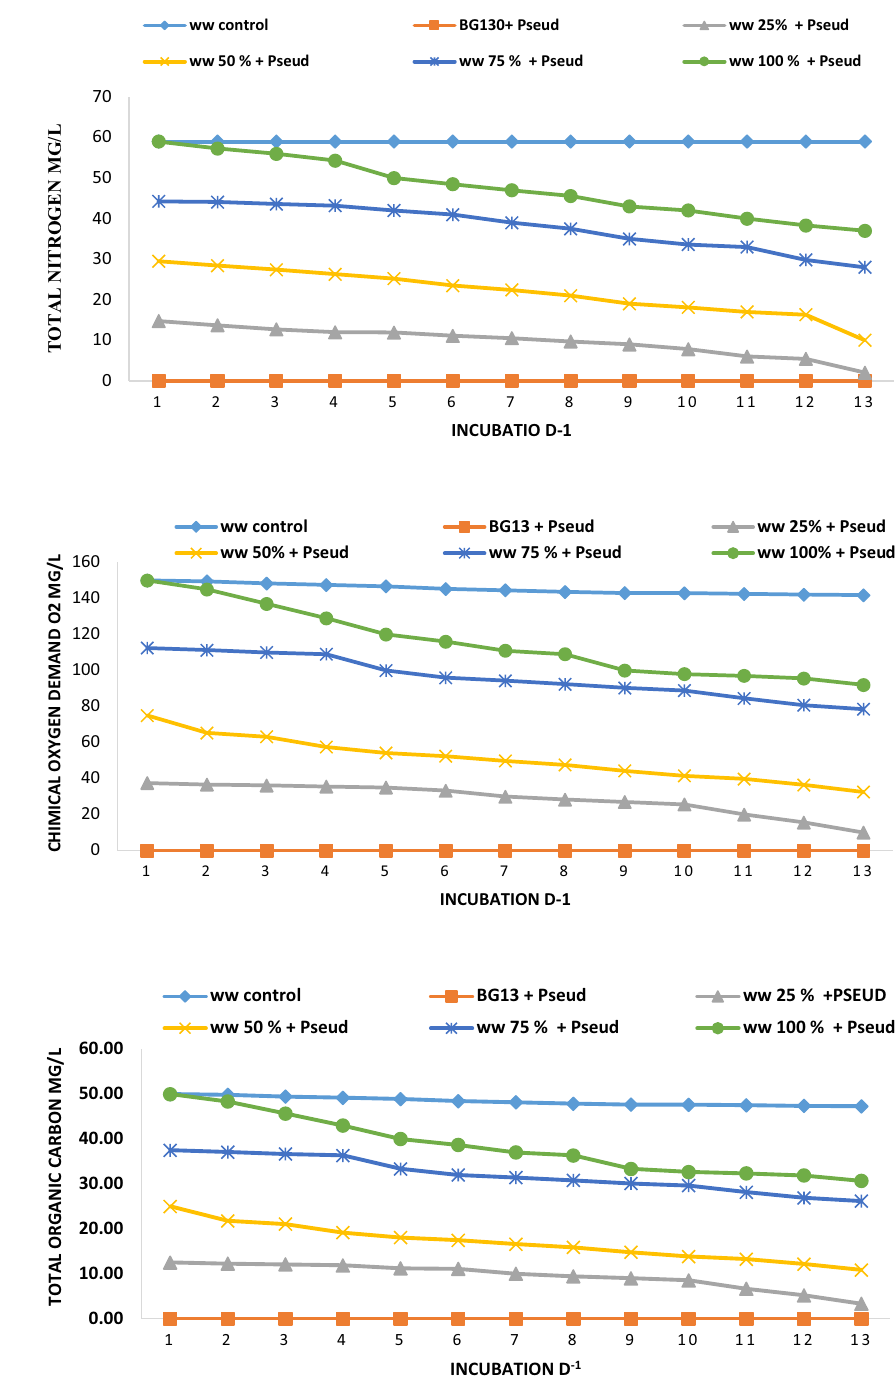
Fig. 7 Removal of total nitrogen Kjeldahl on the same samples of experiment (wastewater control, ww25% + Pseud, ww50% + Pseud, ww75% + Pseud, and ww100% + Pseud)